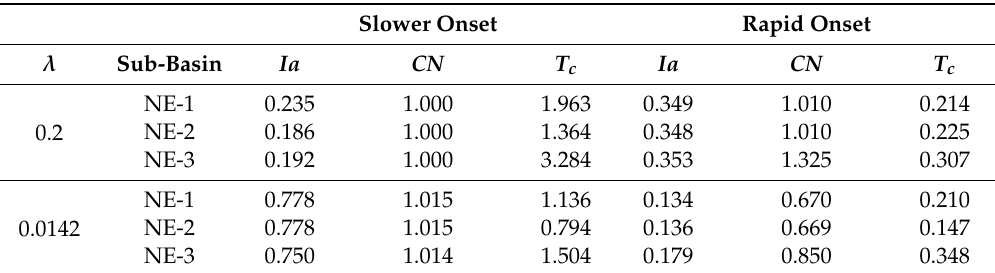
Table 11. Calibration coe ffi cients for transformation of Ia , CN and T c in the three sub-basins of the NE catchment. The coe ffi cients are provided for runo ff events with both slow and rapid onset and for the λ = 0.2 and λ =